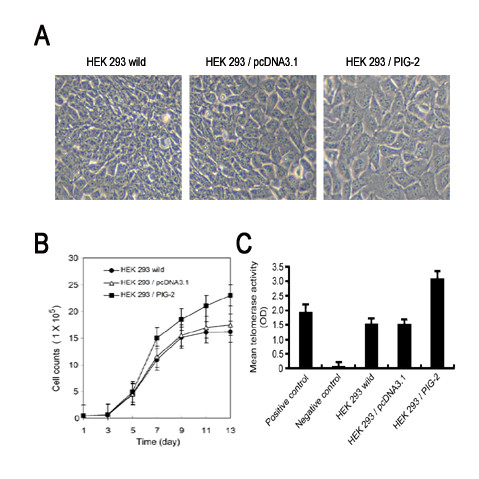
Morphology, growth curve and telomerase activity in PIG-2-transfected HEK 293 cells. (A) Phase-contrast features of wild-type HEK 293 cells (left panel), cells transfected vector alone (middle panel), and cells transfected with PIG-2 gene (left panel). Magnifications, × 100.(B) Growth stimulatory effect of PIG-2 in HEK 293 cells. PIG-2 induces growth stimulation in 293 cells. Viability of 293 cells after transfection with PIG-2 or pcDNA3.1 vector alone, respectively. The data are the number of viable cells grown for 13 days in culture and represent the mean ± S.D. of triplicate determinations. (C) Determination of telomerase activity. Human telomerase-positive embryonic kidney 293 cells, 293 cell extracts treated with RNase (+ RNase), wild-type 293 cells, cells transfected with vector alone and cells transfected with PIG-2 were analyzed by Telomerase PCR ELISA. Assays were performed according to the kit protocol with amounts of extracts equivalent to 1 × 103 cells. The telomerase activity in 293 cells, which served as a positive control, was abolished by pretreatment with RNase. Results are the average mean absorbance values from three separate experiments (means and 95% confidence intervals).